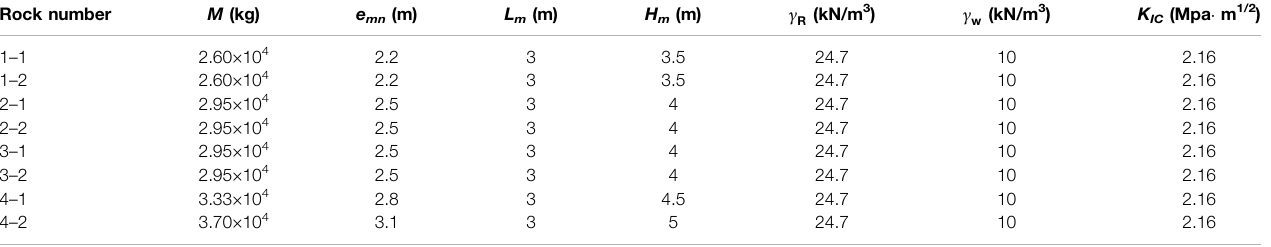
TABLE 2 | Field slope calculation parameters.